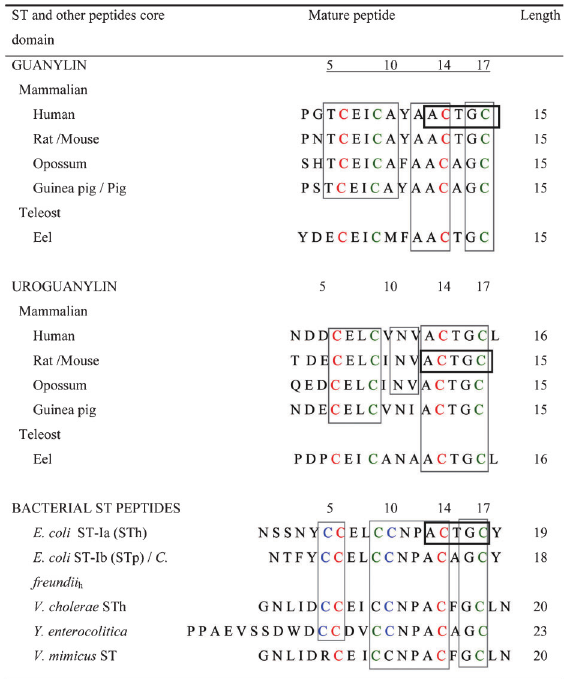
Table 1 for active peptide amino acid sequences). Table 1. Primary biochemical structure and characteristics of peptide ligands of guanylyl cyclase from teleosts, mammals and